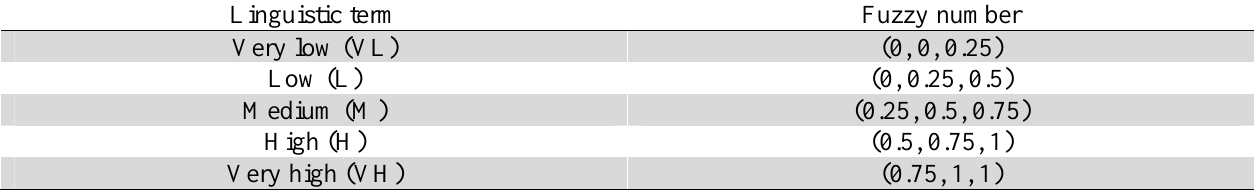
Fuzzy weights for the relative importance of risk factors (Chin et al., 2008; Wang et al., 2009) Linguistic